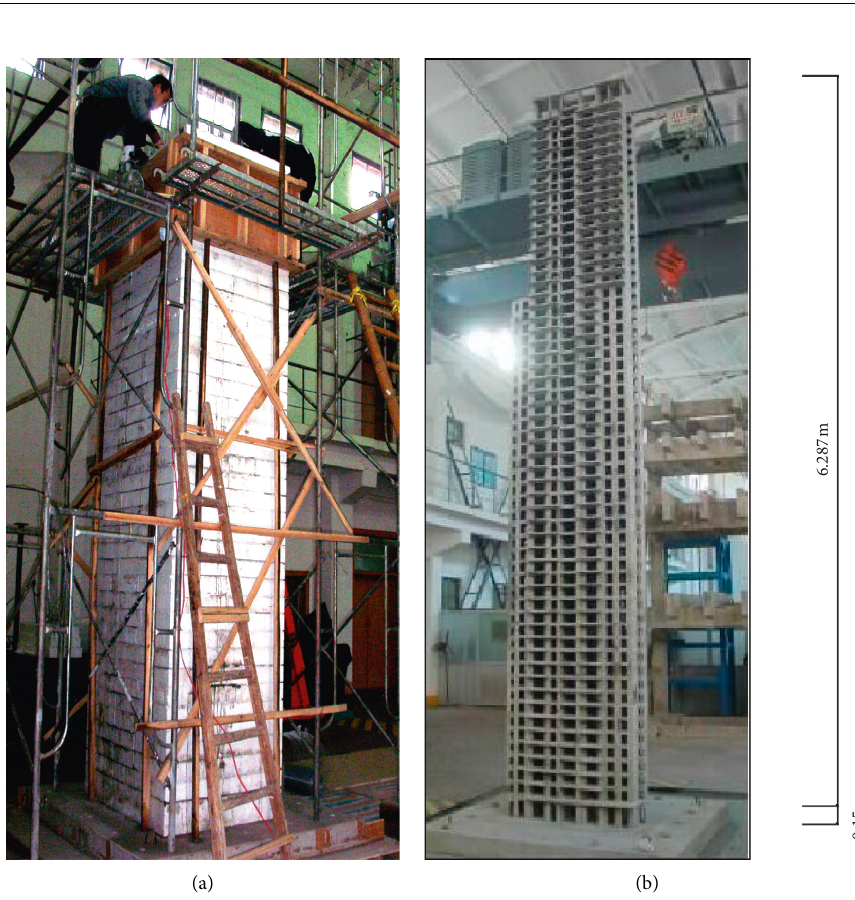
Figure 2: Pictures of the model: (a) model under construction; (b) completed model.